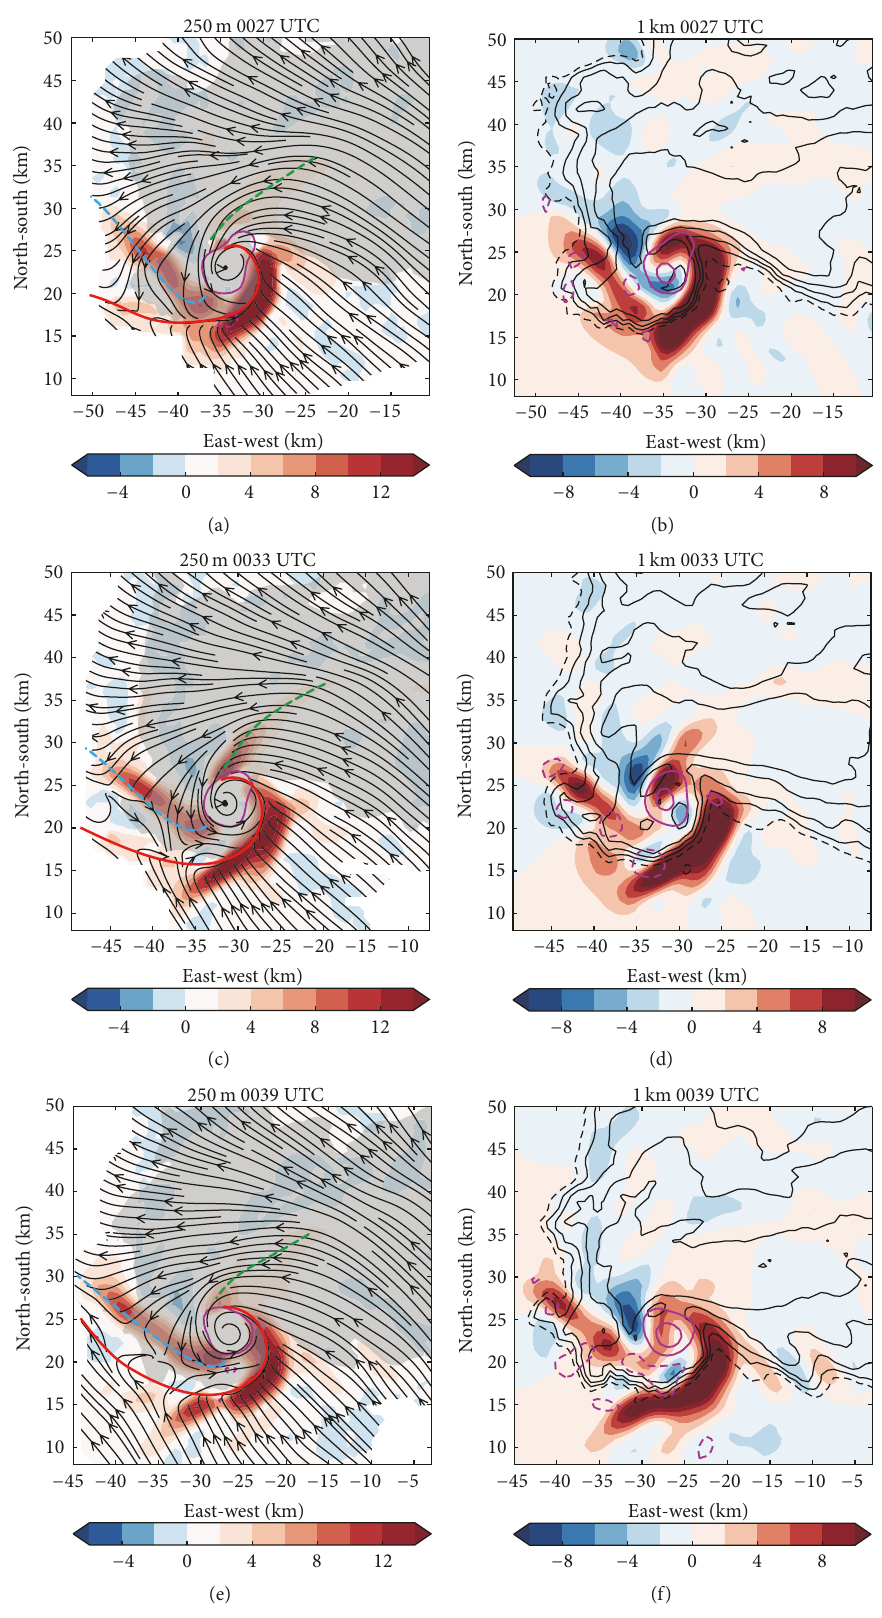
Figure 5: Same as Figure 3, except for during the mature